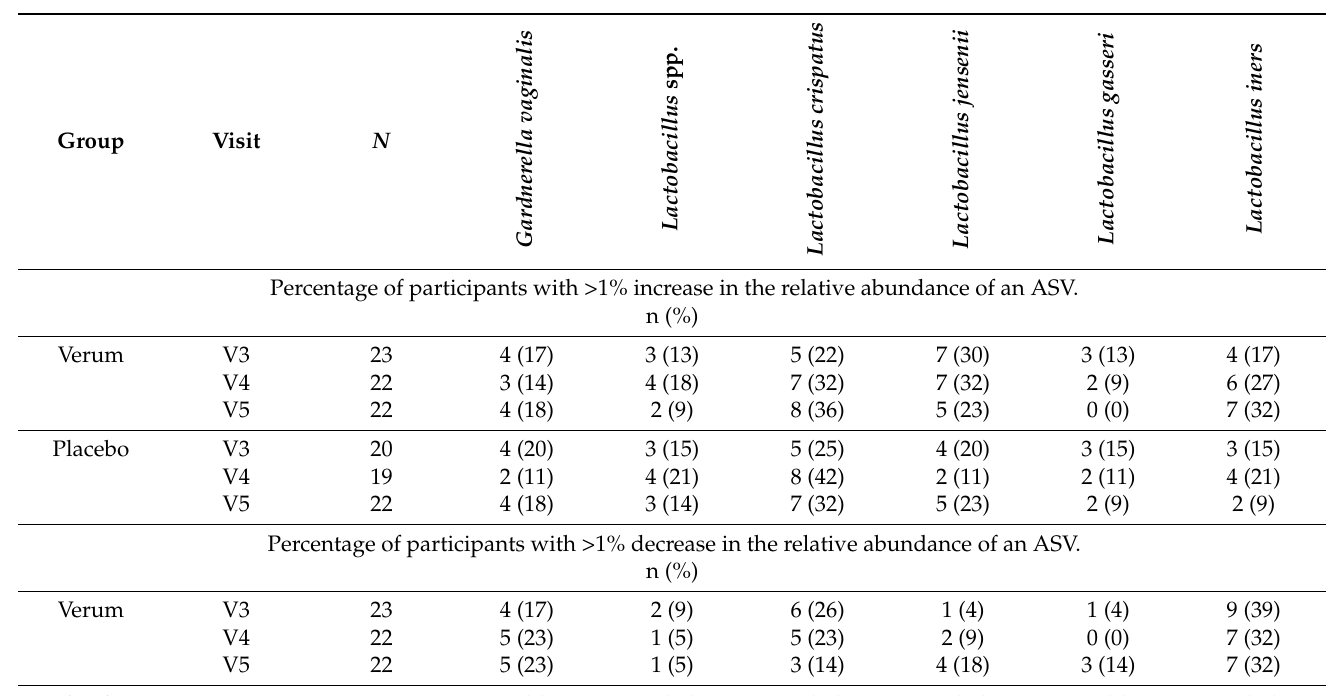
Table 9. Percentage of participants with over 1% change in relative abundance of amplicon sequence variants (ASVs) assigned to predominant Lactobacillus species or Gardnerella vaginalis . V, Visit; V3, after one week of intervention; V4, after two weeks of intervention; V5, after a one-week follow-up.